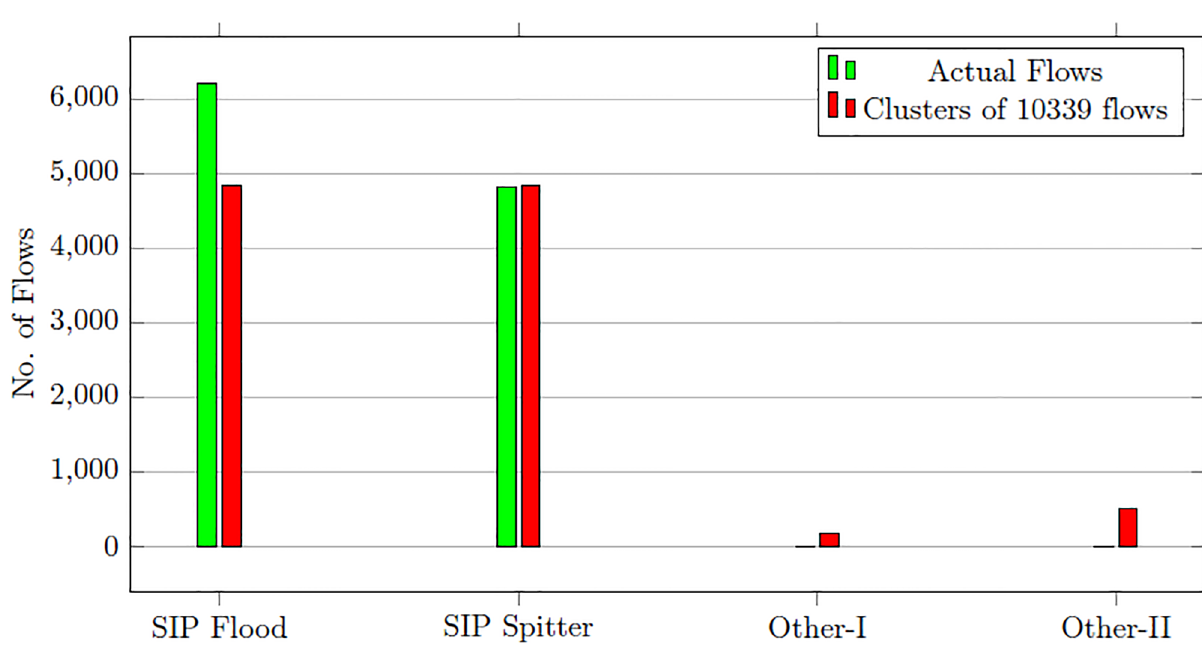
Fig 8. SOM clustering results comparison—SIP